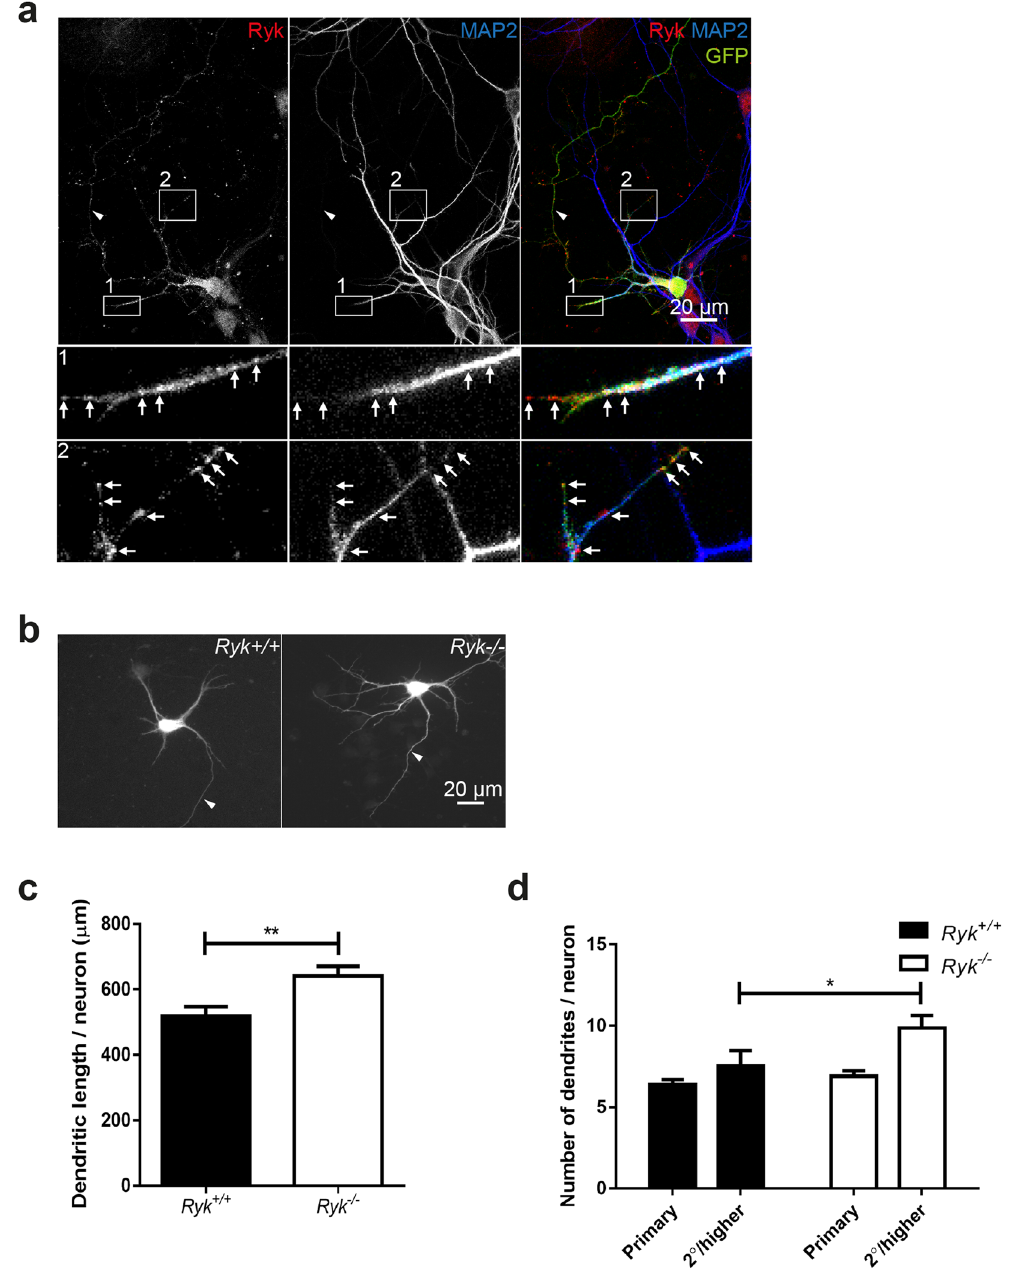
Figure 4. Ryk suppresses cortical dendrite complexity in vitro . ( a ) When transfected into wildtype cortical neurons, FL-Ryk accumulated in puncta along the dendritic shaft and was also localized to dendritic filopodia. Dendrites were identified using anti-MAP2. Bottom panels 1 and 2 are enlargements of insets. Arrows point to FL-Ryk clusters. ( b , c , d ) Dendrite morphogenesis was investigated in DIV5 cultures of cortical neurons isolated from E18.5 Ryk − / − and Ryk + / + cortices. There was a significant increase in dendritic length ( b , c ) and the number of 2°/higher order branches ( b , d ) in Ryk − / − compared to Ryk + / + neurons (6 embryos/genotype; 10 neurons/ embryo; * p = 0.0480; ** p = 0.0039). ( a , b ) Arrowheads indicate the